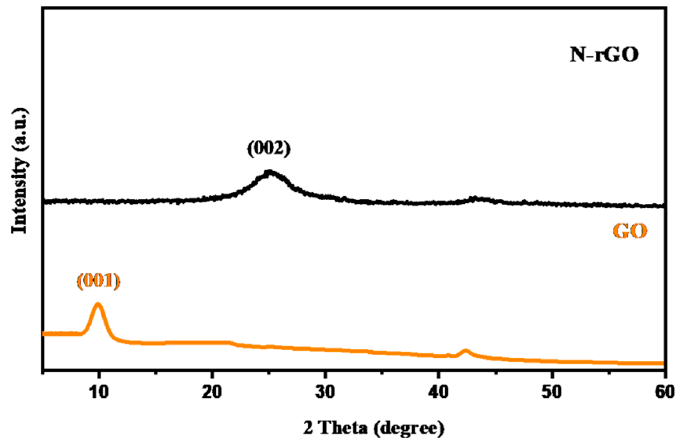
Figure 1. The XRD pattern of GO and N-rGO.